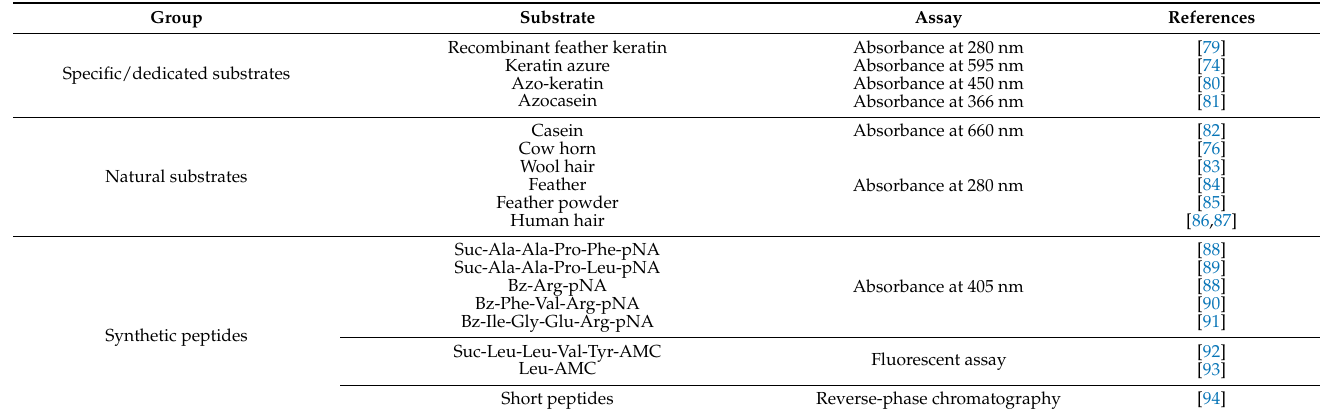
Table 4. Substrates used for proteolytic activity assay of